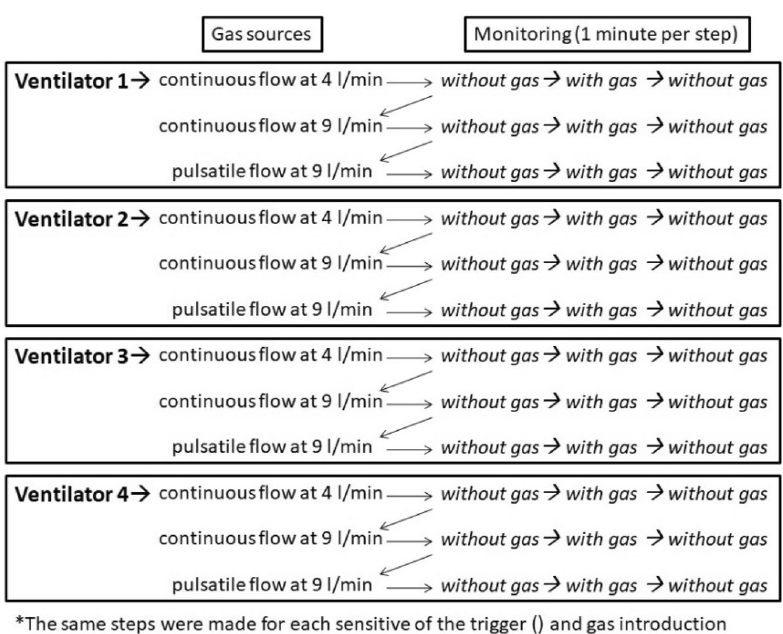
Figure 2. Protocol for testing through different